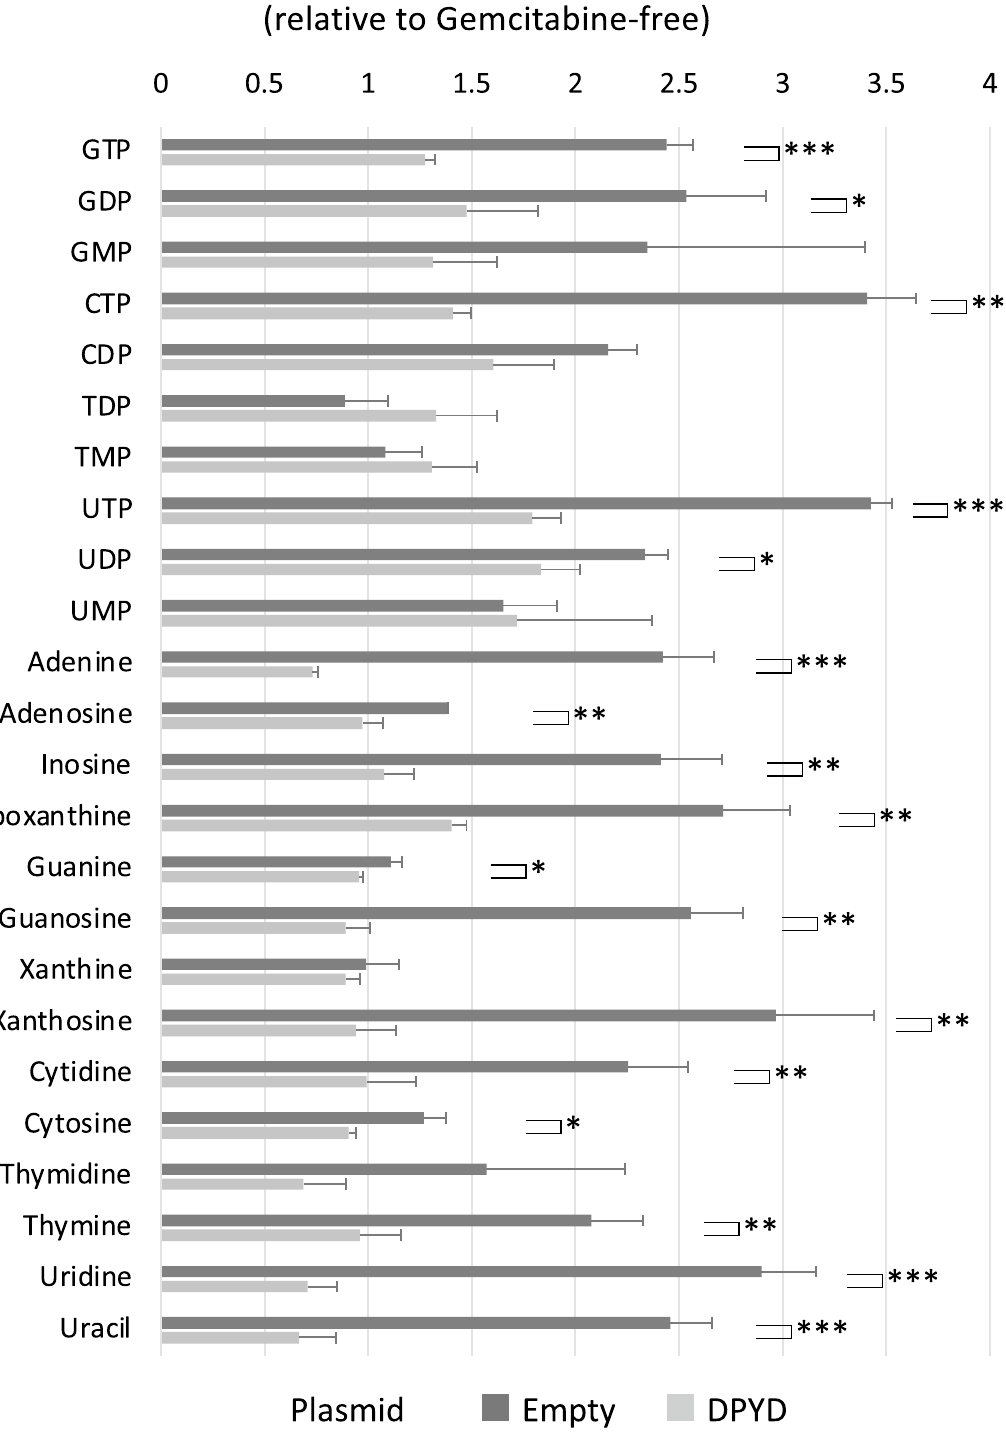
Figure 5. Nucleic acid-related metabolites after exposure to gemcitabine. Nucleic acid-related metabolites in HEK293 cells and DPD-overexpressing HEK293 cells cultured in medium containing 0 or 6.67 nM gemcitabine for 24 h. The concentrations of metabolites when exposed to gemcitabine were corrected against those not exposed to gemcitabine. Boxes, mean; bars, ± SD. * P < 0.05, ** P < 0.01, *** P < 0.001 (Student’s